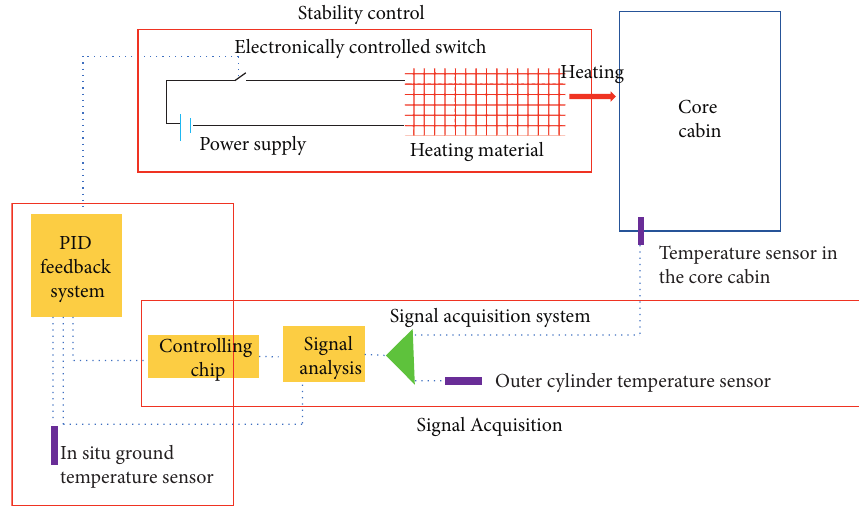
Figure 1: Schematic diagram of the active thermal insulation system.